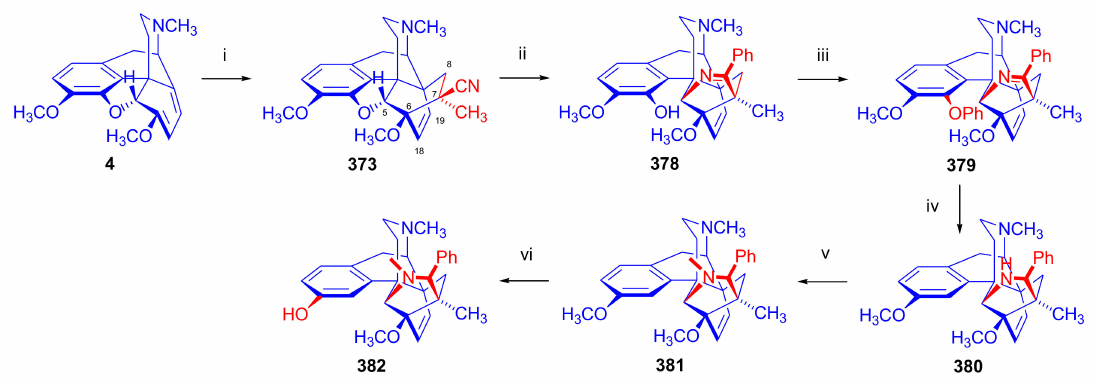
Figure 96. Synthesis of morphinan cyclic imines and pyrrolidines. Reagents and conditions : (i): methacrylonitrile, xylene, reflux, 40 h, 40%; (ii): PhMgBr, benzene; reflux, 18 h; (iii): C 6 H 5 Br, K 2 CO 3 , Cu, pyridine, reflux, 3 days; (iv): 10 eq. Na, NH 3 (l), − 50 ◦ C, 2 h; (v): CH 2 O, NaCNBH 3 , CH 3 CN, DMSO; and (vi): PrSH, NaH, HMPA, 110 ◦ C, 3 h,